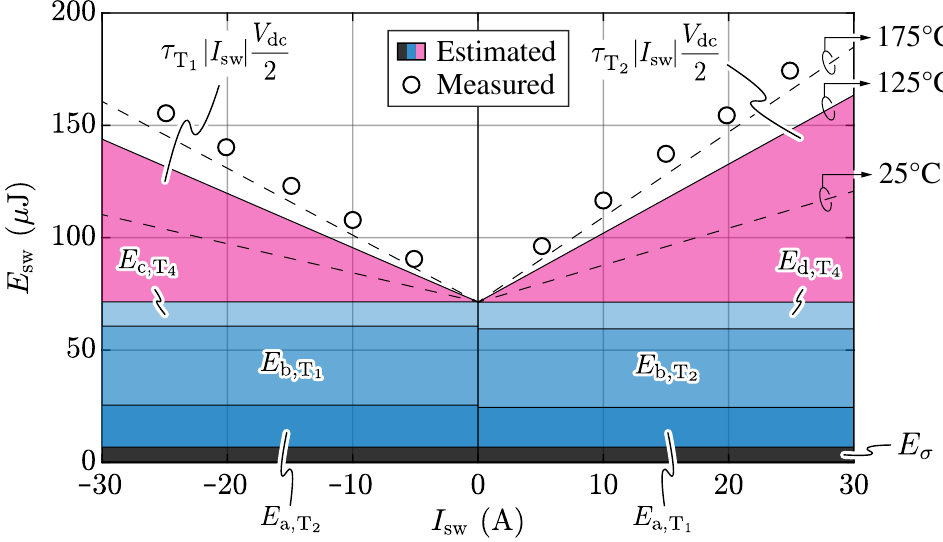
Figure 5. Comparison between estimated and measured hard-switching losses in the 3LTT bridge- leg (T 1 = T 4 : C3M0032120K, T 2 = T 3 : C3M0025065K) as a function of the switched current I sw at V dc = 800V and T j ≈ 125°C. The estimated energy losses take into account the measured parasitic capacitance C σ ≈ 35pF + 50pF (between the switching node and the DC-link, and the winding capac- itance of the load inductor), as E σ = 1 / 2 C σ V 2 sw . The estimated losses for T j = 25°C and T j = 175°C are indicated with dashed